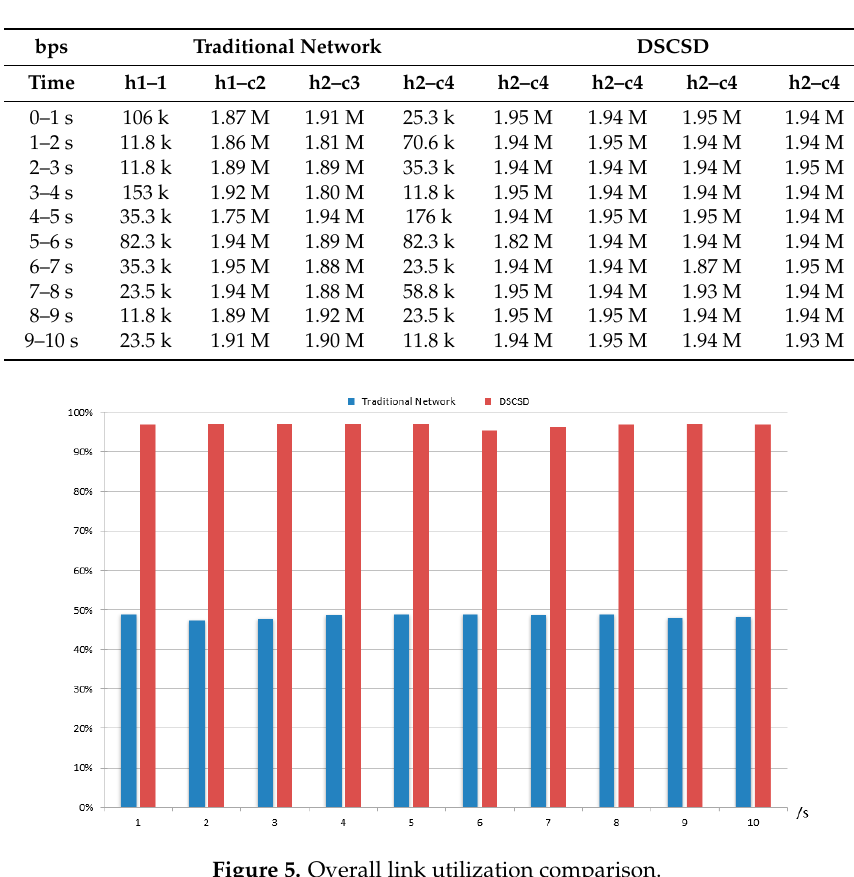
Figure 4. Experimental topology. Table 1. Real-time bandwidth comparison.